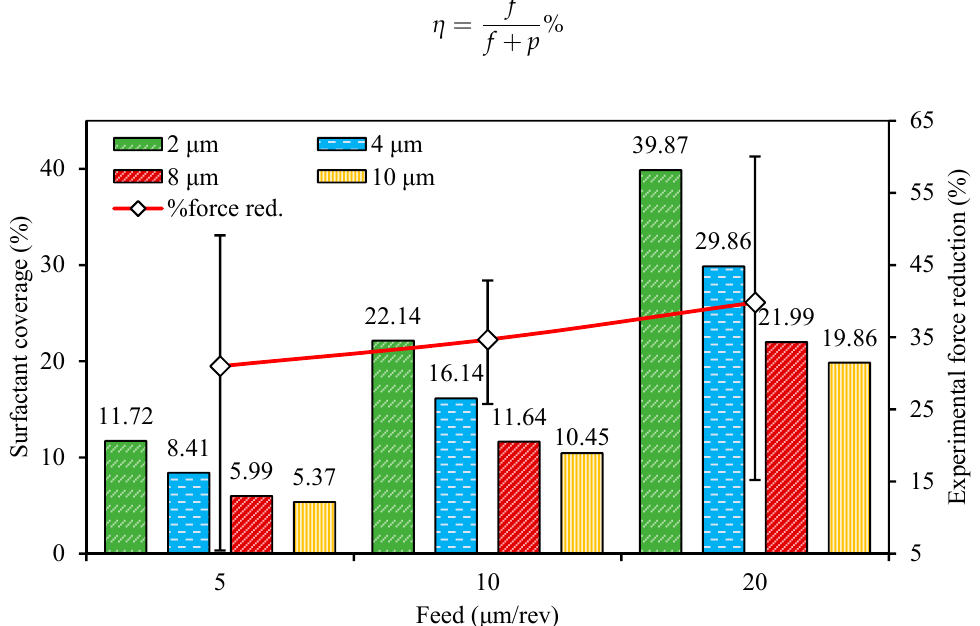
Figure 9. Proportion of the surfactant ‐ affected material in relation to the nominal cutting depths ( a p = 2, 4, 8, 10 μ m) and feed ( f = 5, 10, 20 μ m/rev) and the percentage reduction in cutting force from the experimental results.